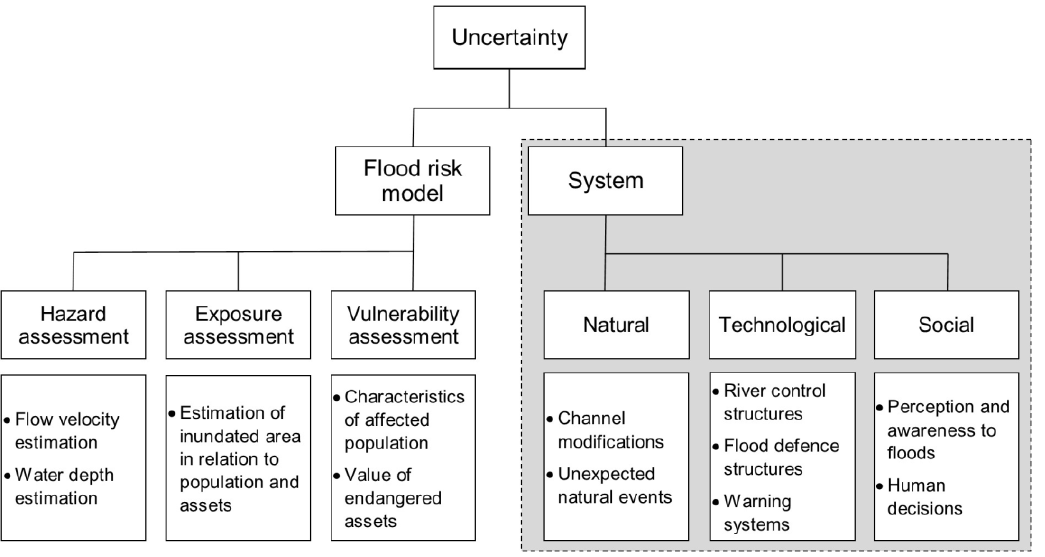
Figure 4. Context of uncertainty related to flood risk.